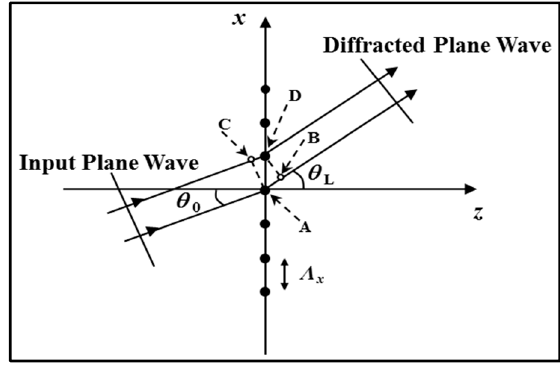
Figure 6. Schematic of diffraction by a thin transmission grating, following [19].